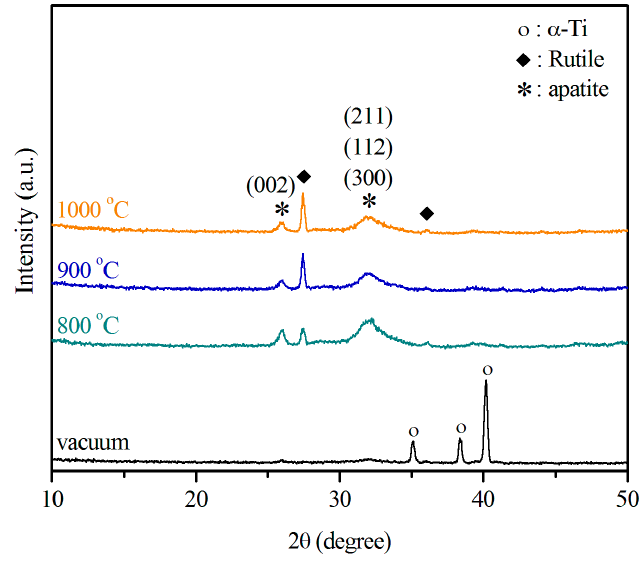
Figure 5. XRD patterns of Ti samples sintered at 800, 900, and 1000 °C in air and of a Ti sample sintered in vacuum after immersion in SBF for 21 days.